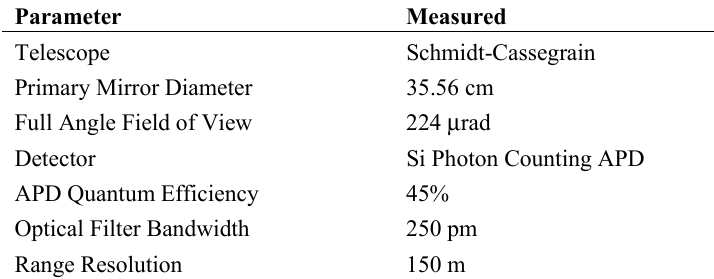
Table 2. A summary of the differential absorption lidar (DIAL) receiver